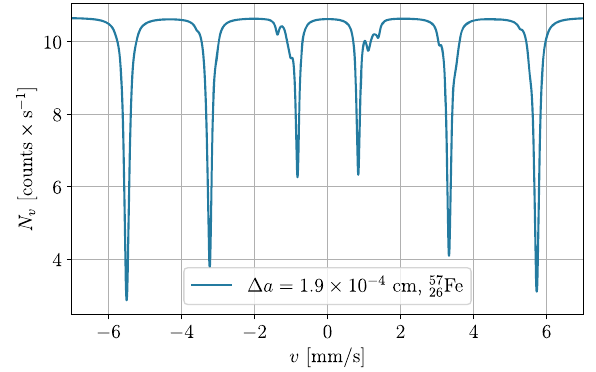
FIG. 3. Simulation of an absorption spectrum obtained with the PMR source. As a target, a nonenriched ( η ¼ 0 . 02 ) α -iron crystal of thickness D ¼ 5 μ m is assumed. The contrast is determined via the ratio of the electron and the nuclear contributions into the crystal polarizability near the resonance frequency and in the case of α -iron ∼ 20 . Other parameters are as in Fig. 2, with Δ a ¼ 1 . 9 × 10 − 4 cm. The electronic “ background ” is supposed to be removed via temporal gating to obtain the results.